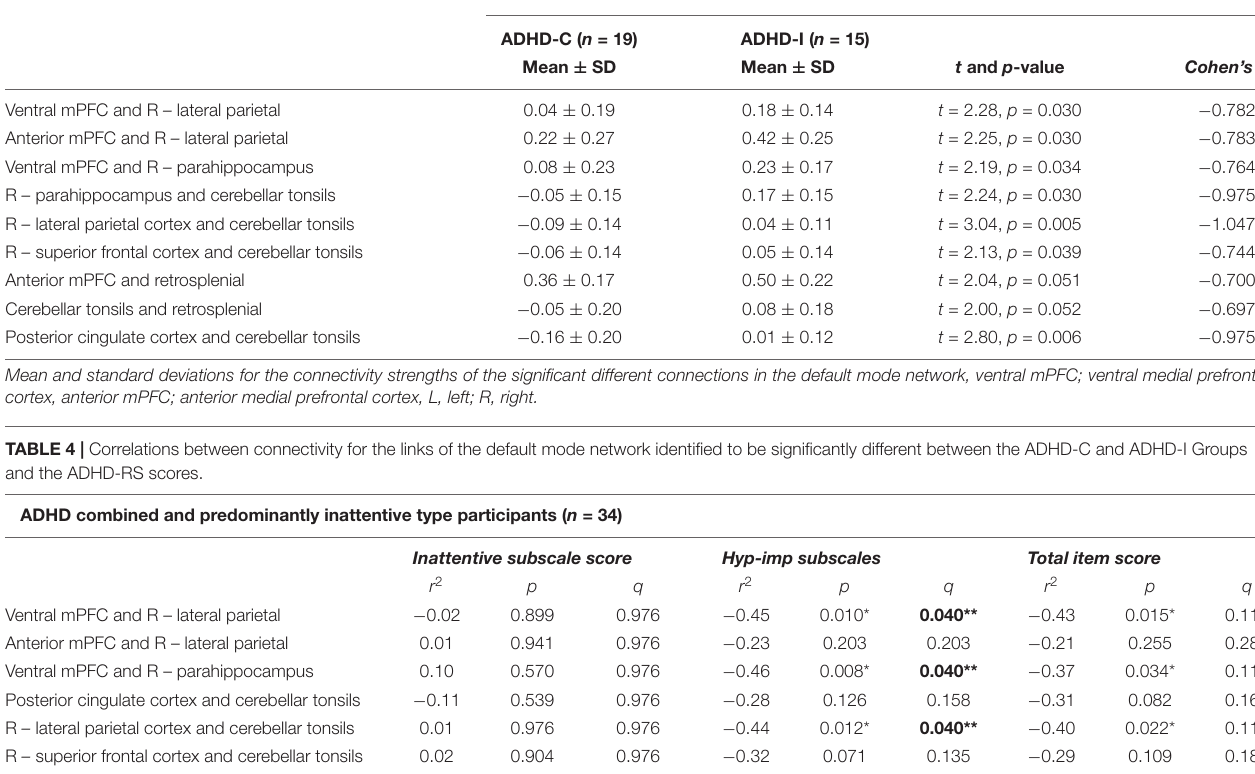
TABLE 3 | Nodes of the default mode network identified to be significantly different between ADHD-C and ADHD-I groups using network-based statistical analysis. Significant network connections (AAL Regions)